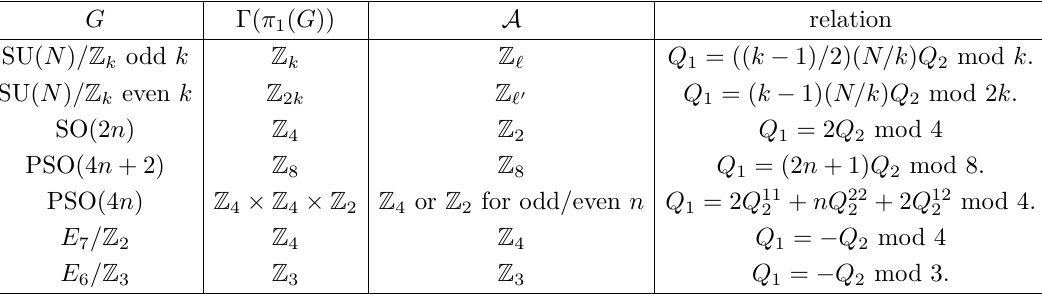
Table 2 . The instanton (continuous and discrete) 0-form symmetry in 5d gauge theory with gauge group G and without Chern-Simon term, given by (U(1) × Γ( π ‘ = gcd((( k − 1) / 2)( N/k ) , k ) , ‘ 0 = gcd(( k − 1)( N/k ) , 2 k )